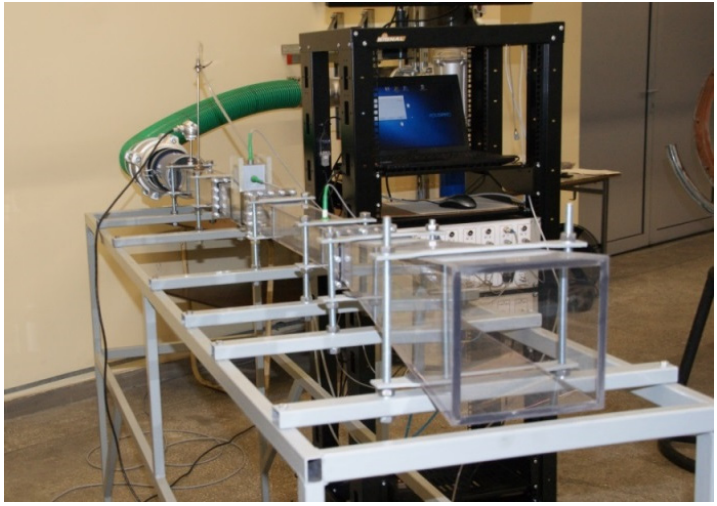
Figure 3. Test stand.